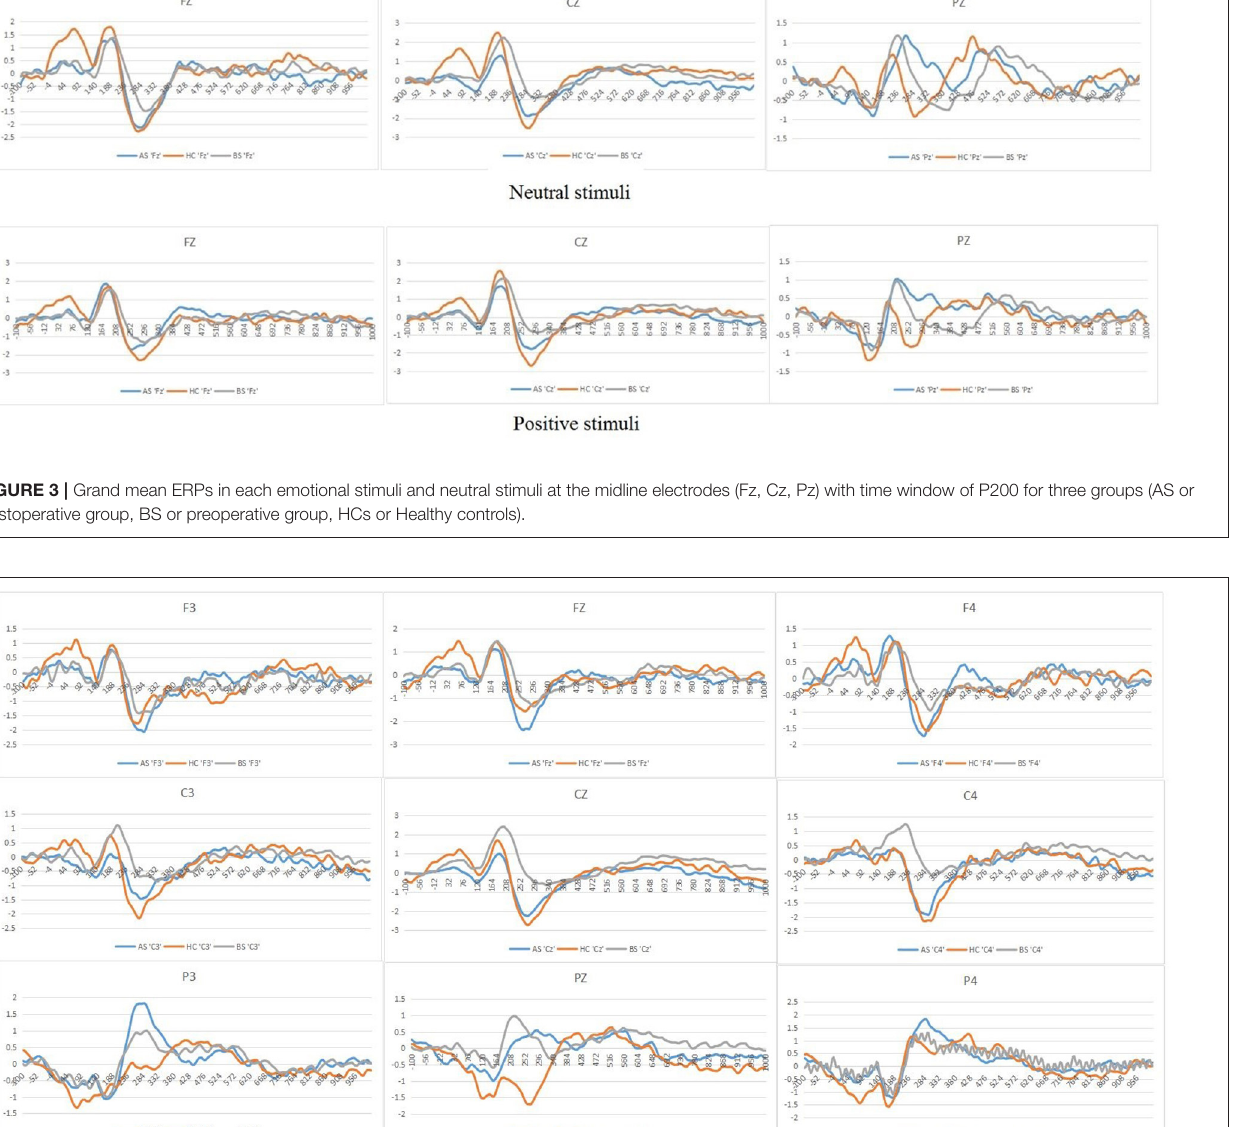
= 0.07], but the Stimuli was clearly significant in the HCs [ F (2, 73) = 7.45, p p